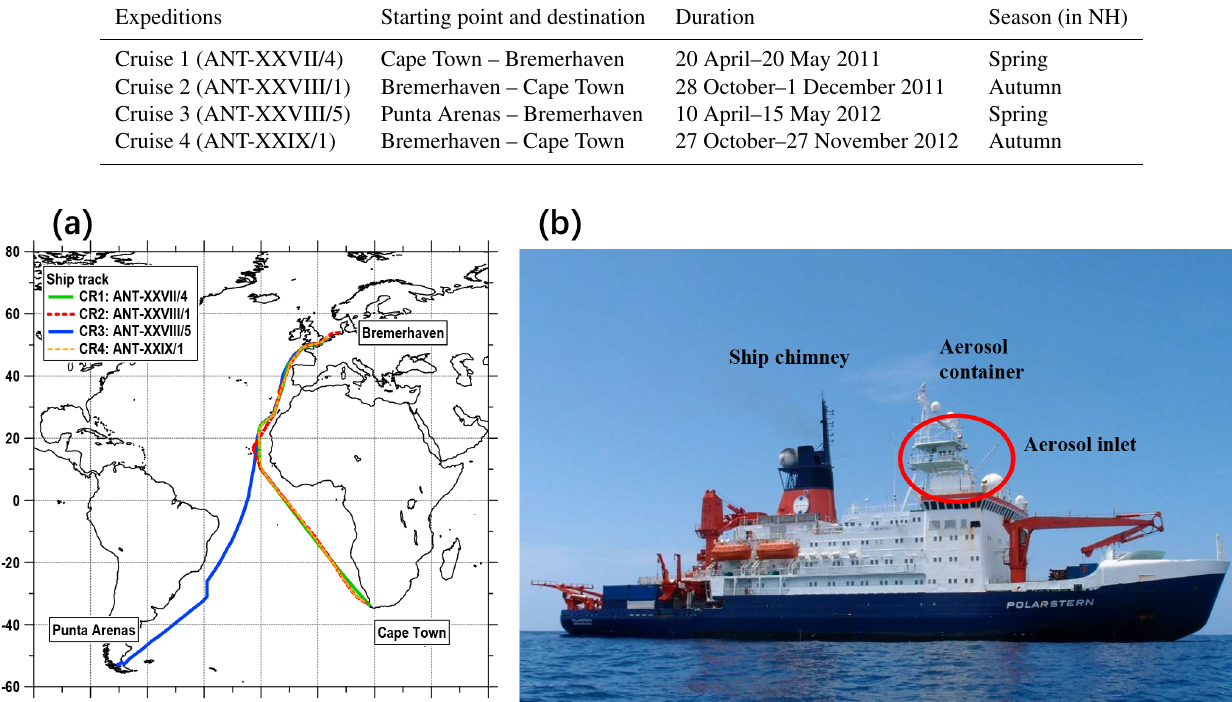
Figure 1. (a) Ship tracks of four cruises; (b) The position of the container during Polarstern